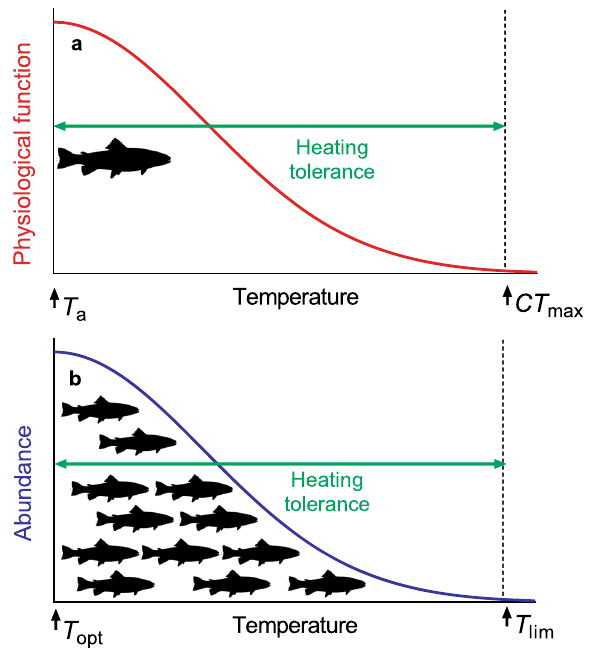
Fig. 1 Conceptual illustration of fi sh heating tolerances at different biological scales. a At the individual level, T a represents the temperature an individual is acclimated to in a laboratory experiment, and CT max is the temperature coinciding with death or loss of critical functions. b At the population level, T opt is the temperature of highest abundance in the wild, and T lim is the 95th percentile of maximum temperatures encountered by that species in its natural